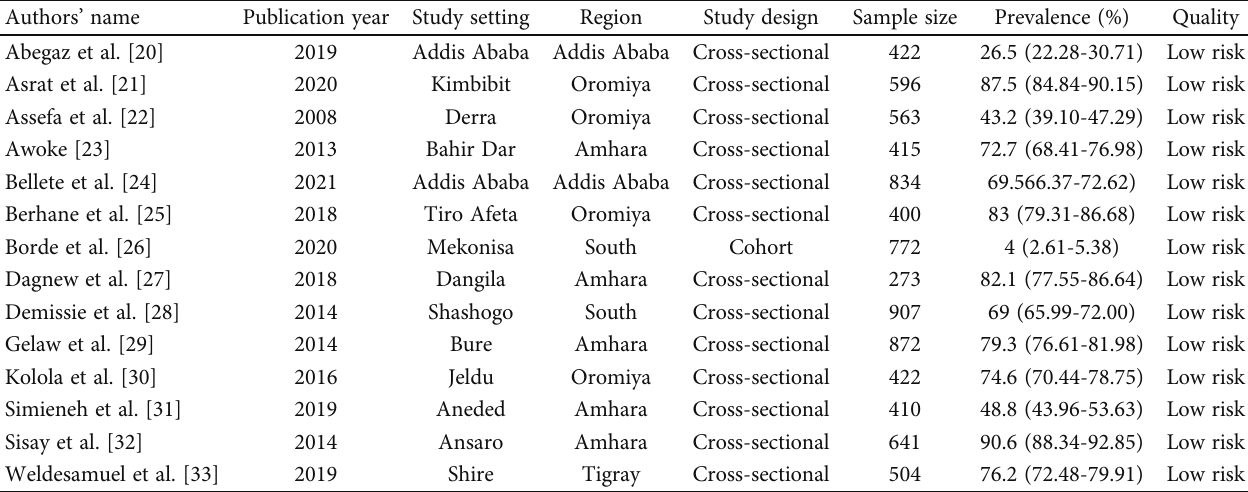
Figure 1: PRISMA fl owchart diagram of the study selection. Table 1: Characteristics of the included studies in the systematic review and